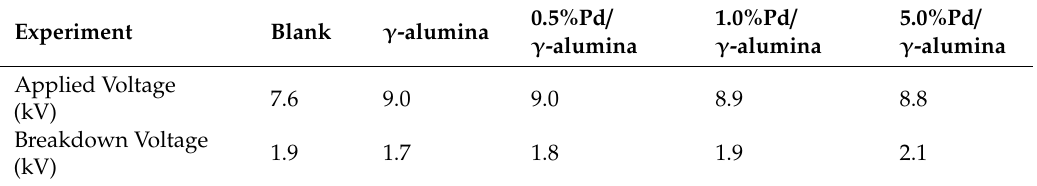
Table 1. Applied voltage and breakdown voltage for the non-packed reactor (Blank) and the packed